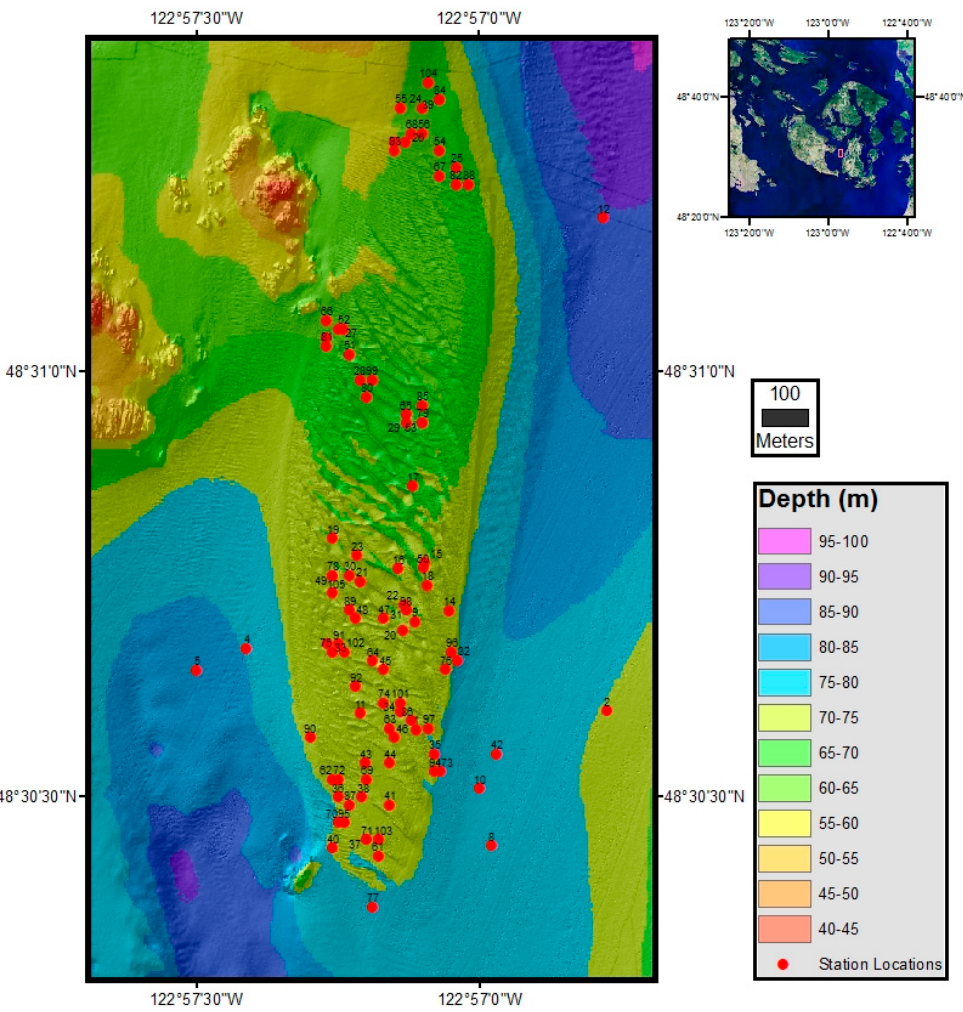
Figure 2. Expanded view of multi-beam echo sounder (MBES) bathymetric image of the San Juan Channel sediment wave field exhibited in Figure 1 with depth illustrated in color. Small dots within circles represent sediment sample locations (diameter of dot equals ~23 m), station numbers are located next to open circles.